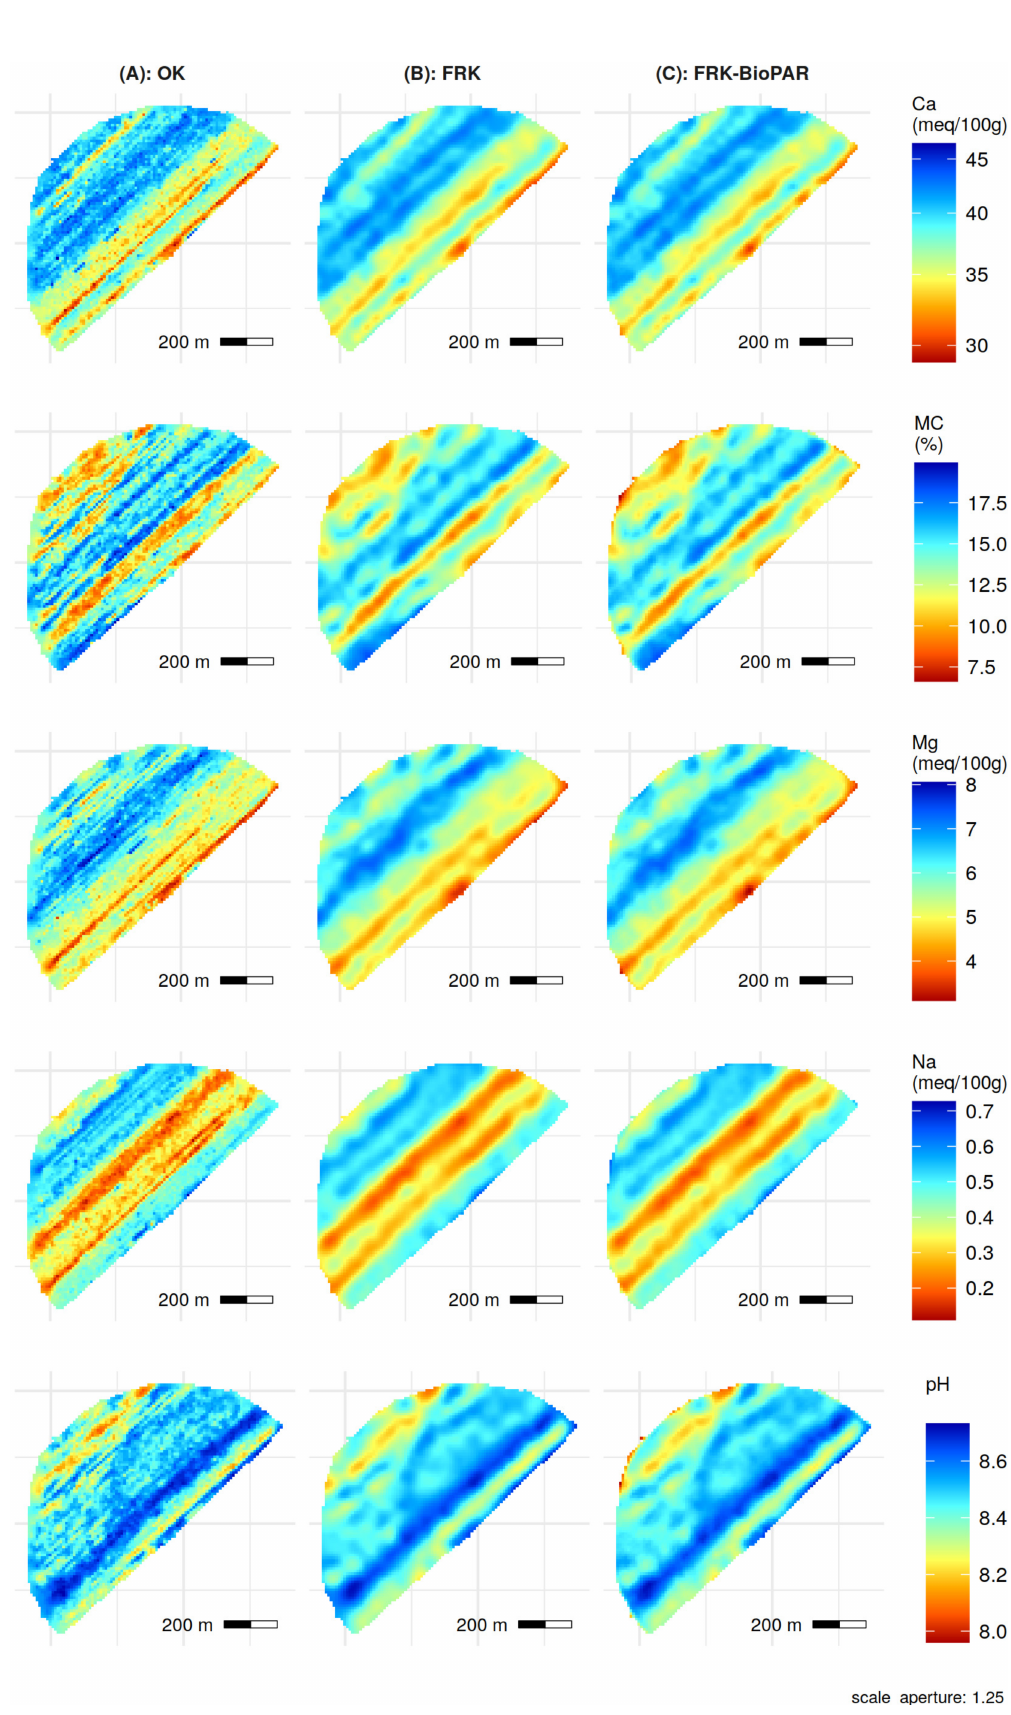
Figure 8. OK predictions ( A ), FRK predictions ( B ), FRK-BioPAR predictions ( C